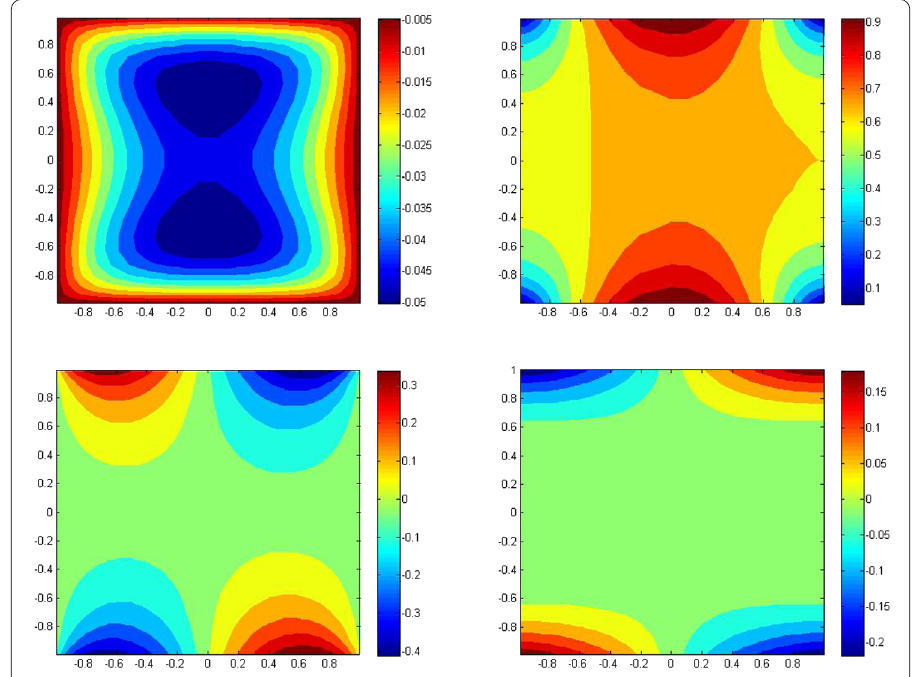
Figure 3 Two-dimensional discrete solution for the data defined in (37)